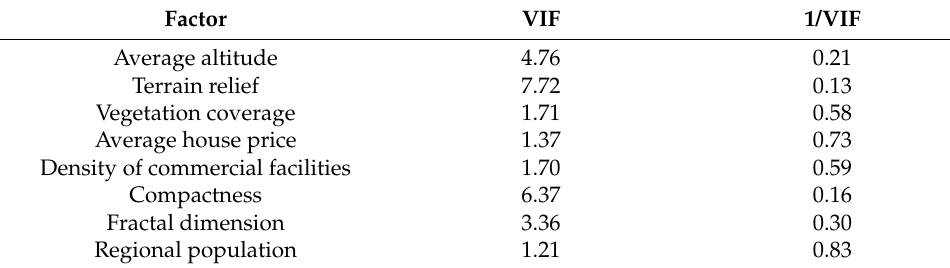
Table 2. Variance inflation factor (VIF) of each